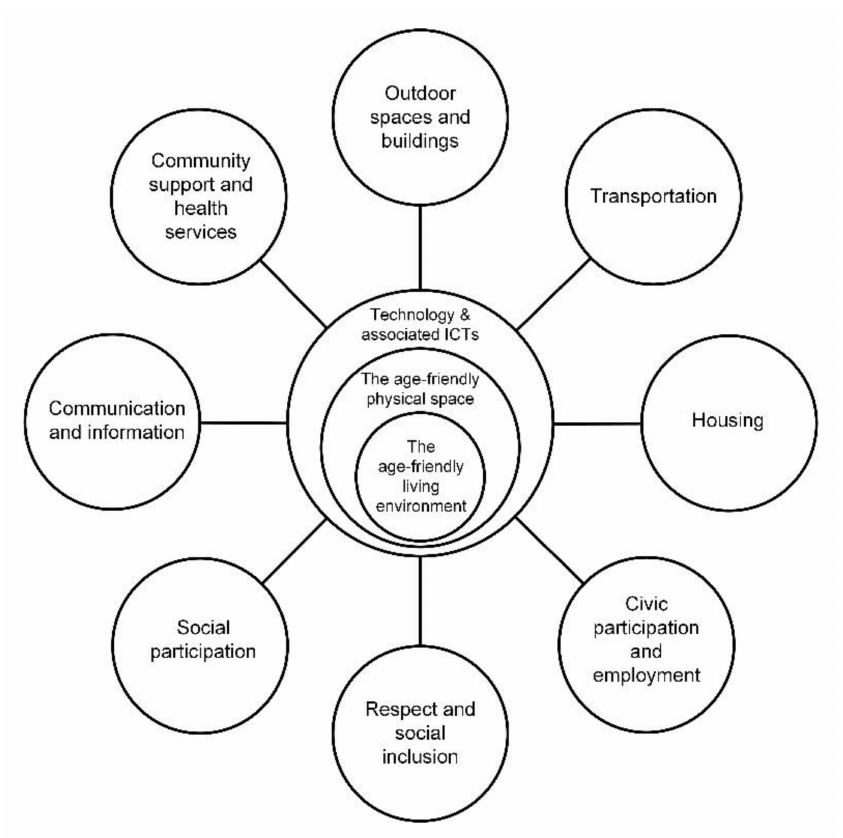
Figure 2. The Smart Age-friendly Ecosystem (SAfE) framework [48]. Permission granted by Drs Marston and van